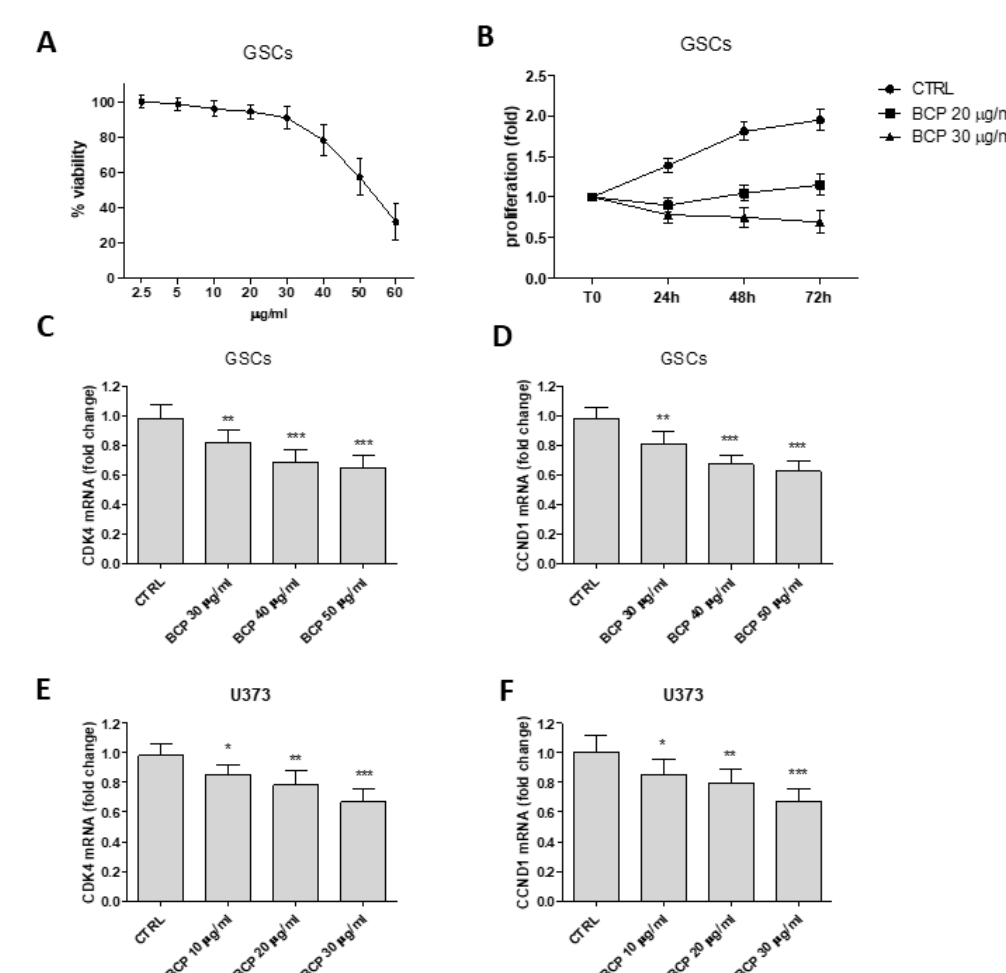
Figure 6. Dose response curve of cell viability assessed in GSCs treated with BCP (panel A ). Values are expressed as percentage of reduction of viability with respect to the untreated control. Cell proliferation evaluation at T0, 24, 48 and 72 h in GSCs treated with BCP (panel B ). Values are expressed as fold change of viability with respect to the untreated control at T0. Evaluation of CDK4 an CCND1 mRNA in GSCs and U373 cells treated with BCP at di ff erent doses (panels C – F ). Data are calculated according to the 2 − ∆∆ Ct method as fold change relative to normal controls and expressed as means ± SD. * p < 0.05, ** p < 0.01, *** p < 0.001, vs. the control.